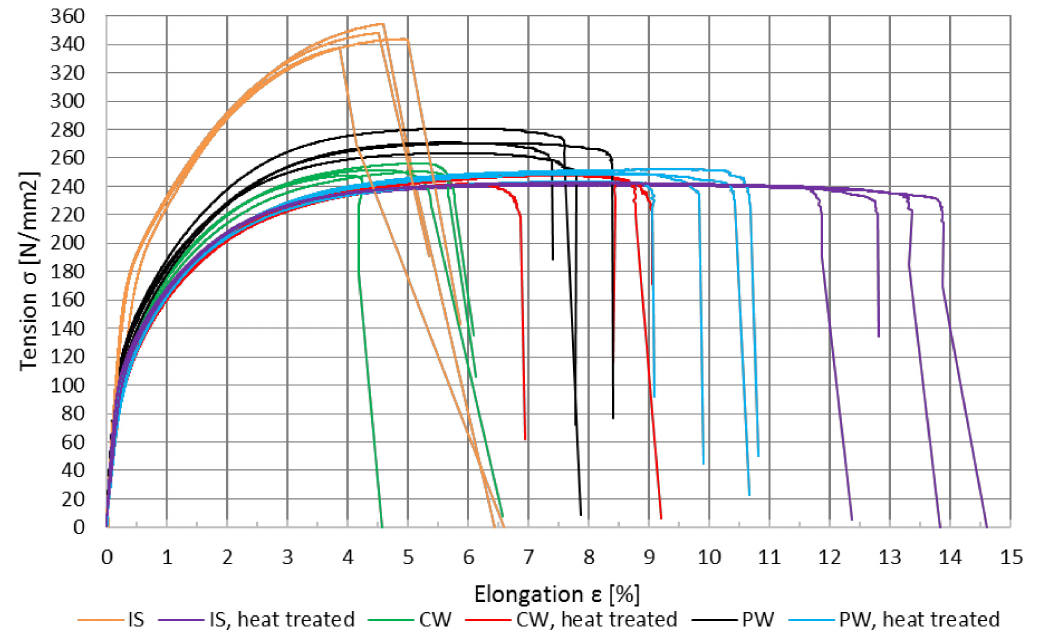
Figure 24. Stress elongation curves depending on the post-treatment of the tensile specimens. While the tensile specimens in the initial state (IS) exhibit no necking accompanied with a reduction in the tension before fracture, annealing and laser polishing results in a visible material flow by necking in the surrounding area of the fracture, see Figure 25. Without laser polishing, the position of break between the specimens with and without (IS) heat treatment (IS, heat treated) strongly varies between the specimens. The polished samples exhibit similar breaking positions around the area, with the greatest remelting depth independent from the applied heat treatment.